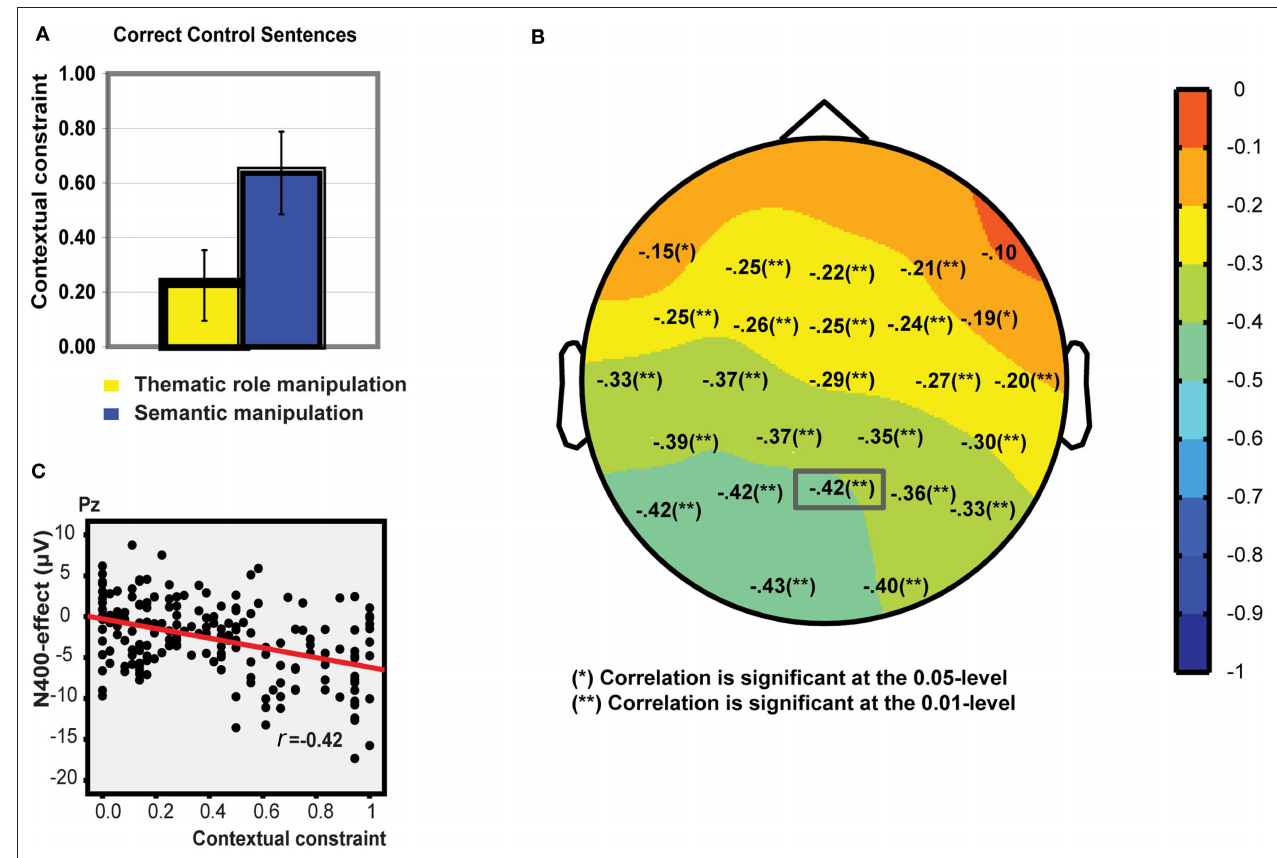
FiguRE 4 | (A) Mean contextual constraint values for the correct control sentences of the thematic role violations and the semantic violations. (B) Correlations between contextual constraint and N400 effect per electrode and their topographical distribution. (C) Scatter diagram and best-fitting regression line of contextual constraint and N400 effect values per thematic role and semantic item at electrode